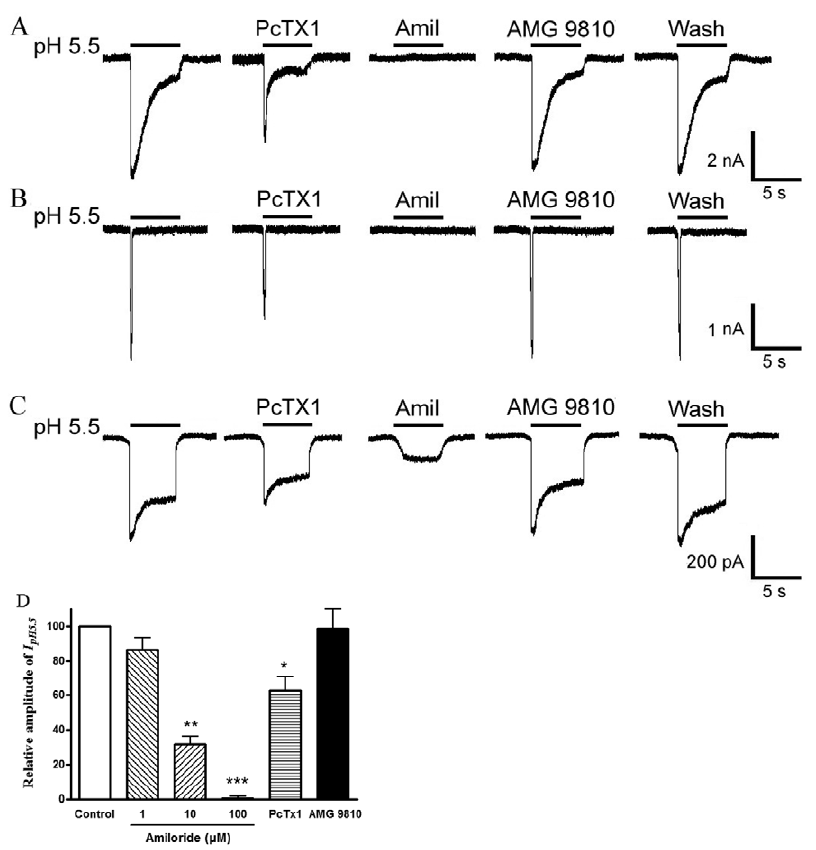
Figure 1. Three types of proton-gated currents in rat DRG neurons. Three types of proton-gated currents were recorded in DRG neurons. Example traces of a slow-inactivating current followed by a small sustained component (A), and a fast-inactivating current (B), a sustained current with a small transient phase (C). All three types of proton-induced currents could be partly inhibited by 10 nM PcTx1, a specific antagonist of homomeric ASIC1a channels. These currents could be completely or partly blocked by 100 m M amiloride (Amil), a broad-spectrum ASIC channel blocker. The TRPV1 blocker AMG 9810 (1 m M) has little effect on the transient peak phases of three types of acid currents. The bar graph in (D) shows relative amplitude of peak currents induced by pH 5.5 after application of amiloride, PcTx1 and AMG 9810. Proton-induced currents were evoked by extracellular application of a pH 5.5 solution for 5 s. *P , 0.05,**P , 0.01, ***P , 0.001, one way analysis of variance followed by post hoc Bonferroni’s test, compared with control. Each column represents the mean 6 SEM of 8–11